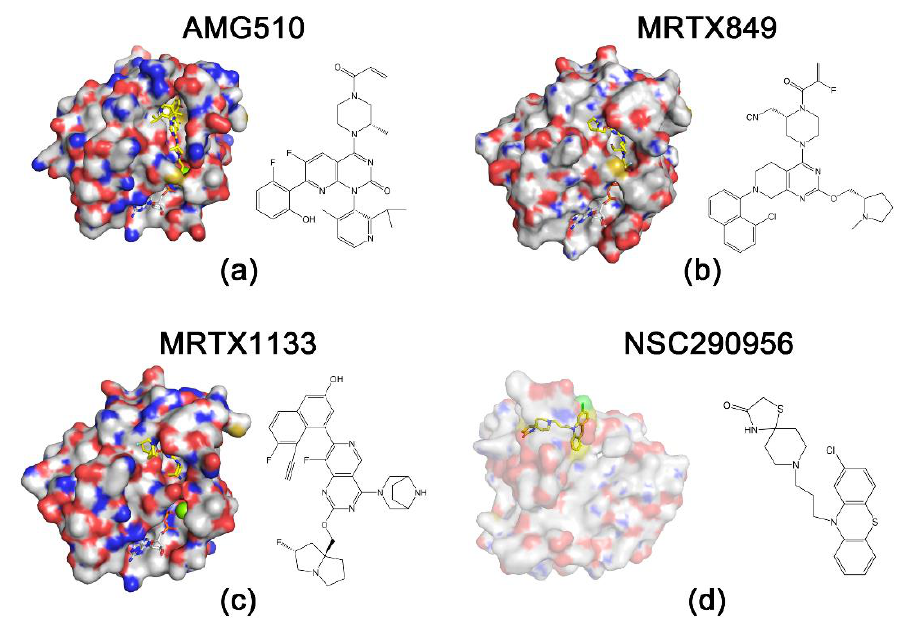
Figure 2. Structures of RAS proteins and inhibitors. Protein is indicated by surface representation, and compounds and nucleotides are shown in stick models. The carbon and hydrogen atoms of the inhibitor are marked in yellow to highlight them. ( a ) KRAS G12C and AMG510 (Protein Data Bank (PDB): 6OIM). ( b ) KRAS G12C and MRTX849 (PDB: 6UT0). ( c ) KRAS G12D and MRTX1133 (PDB: 7RPZ). ( d ) HRAS G60A and NSC290956 [14].